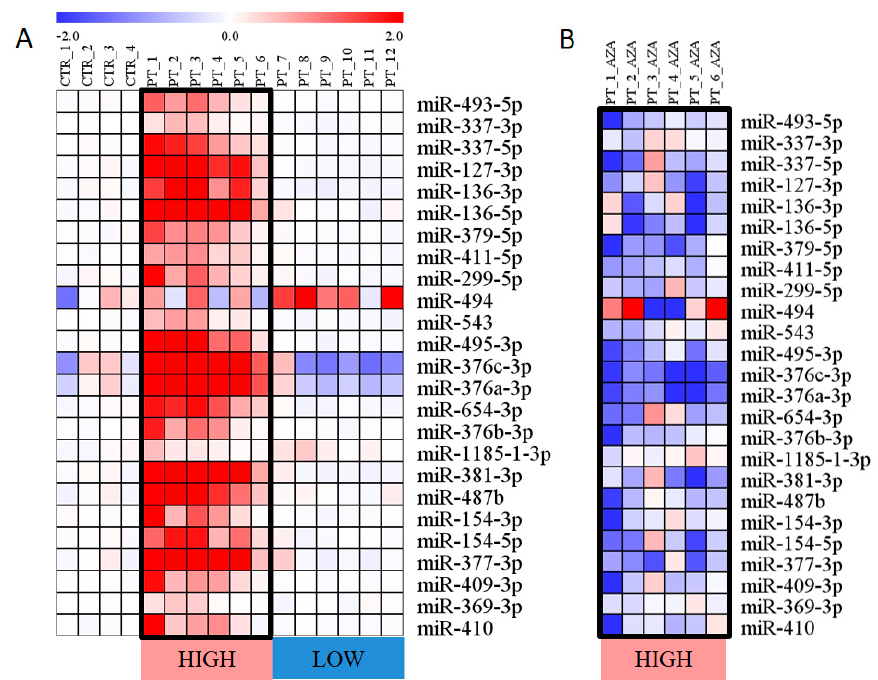
Figure 2. Expression of miRNAs encoded in the DLK1–DIO3 region. ( A ) miRNA expression in untreated patients (PT) and healthy controls (CTR). The expression level is calculated as the binary logarithm of fold change (logFC) compared to the mean expression of controls. The miRNAs are aligned in the heatmap according to their location on chr14. ( B ) Reduction of miRNA expression following AZA treatment. The changes in miRNA levels are calculated as the logFC between paired samples (AZA treatment vs. pretreatment). Only those patients with miRNA overexpression before treatment are shown. Both heatmaps use a color gradient intensity scale to express visually the logFC values in a range of colors (blue—downregulation, red—upregulation, white—unchanged expression).